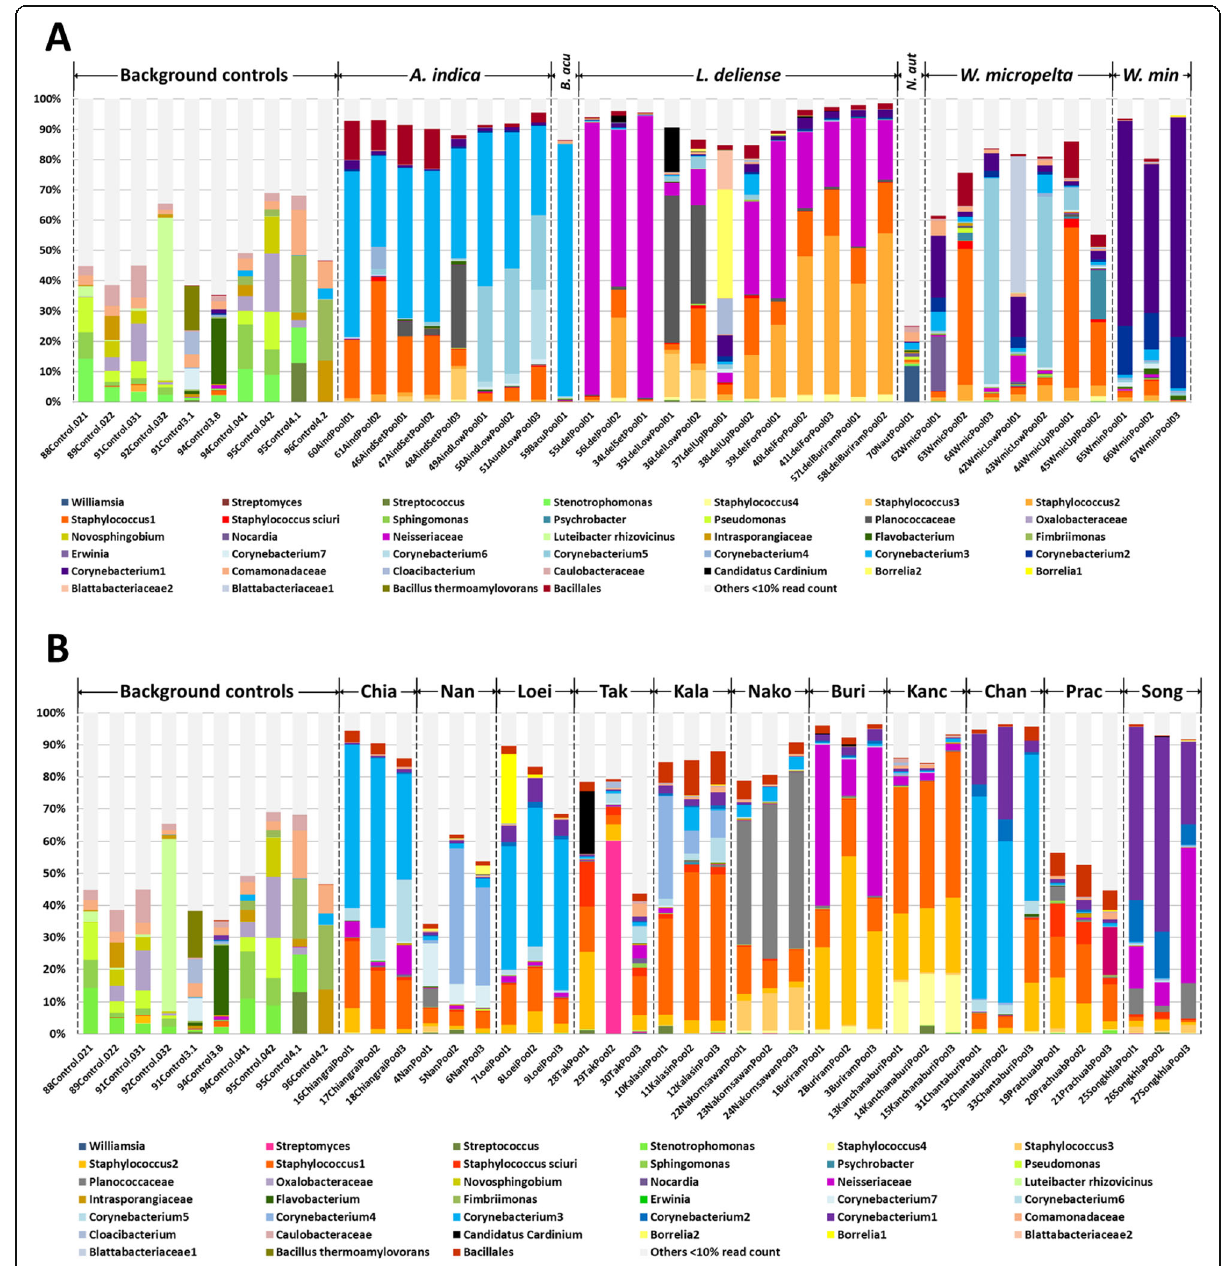
Fig. 6 Relative abundance of bacterial OTUs in background controls and pooled samples. a Pools by chigger species (50 individuals per sample). b Mixed chigger species (50 individuals per sample) pooled by province. The data are filtered; OTUs that represented < 10% in a sample were combined in “ others ” (light grey) to aid visualisation. Source data are included in Additional file 2: Table